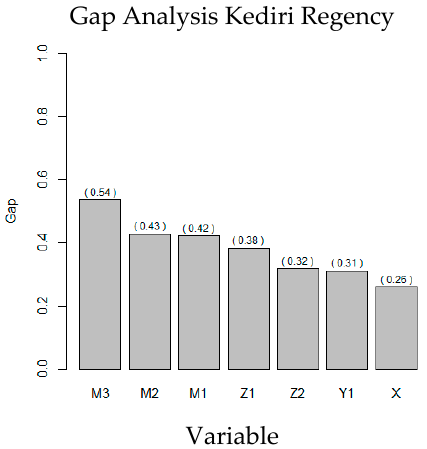
Figure A7. Bar Diagram of Gap Analysis of Kediri Regency.